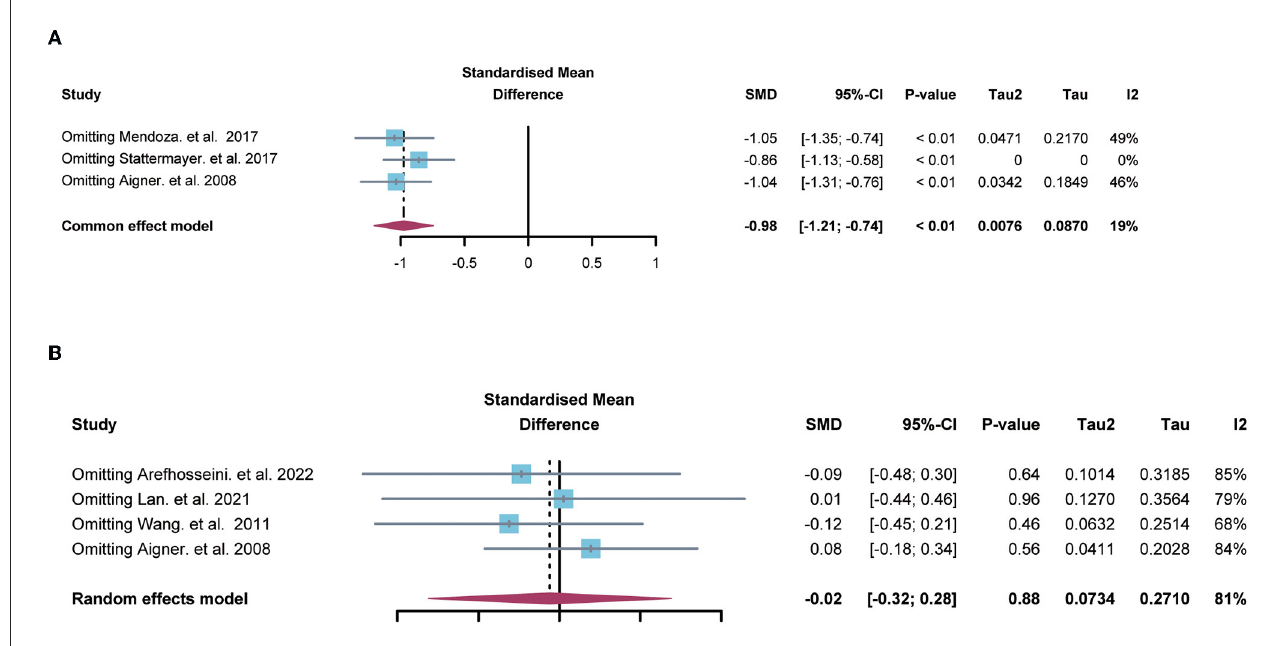
FIGURE3 The forest plots showing the sensitive analysis of hepatic (A) and serum copper (B) . SMD, standardized mean differences; CI, confidence